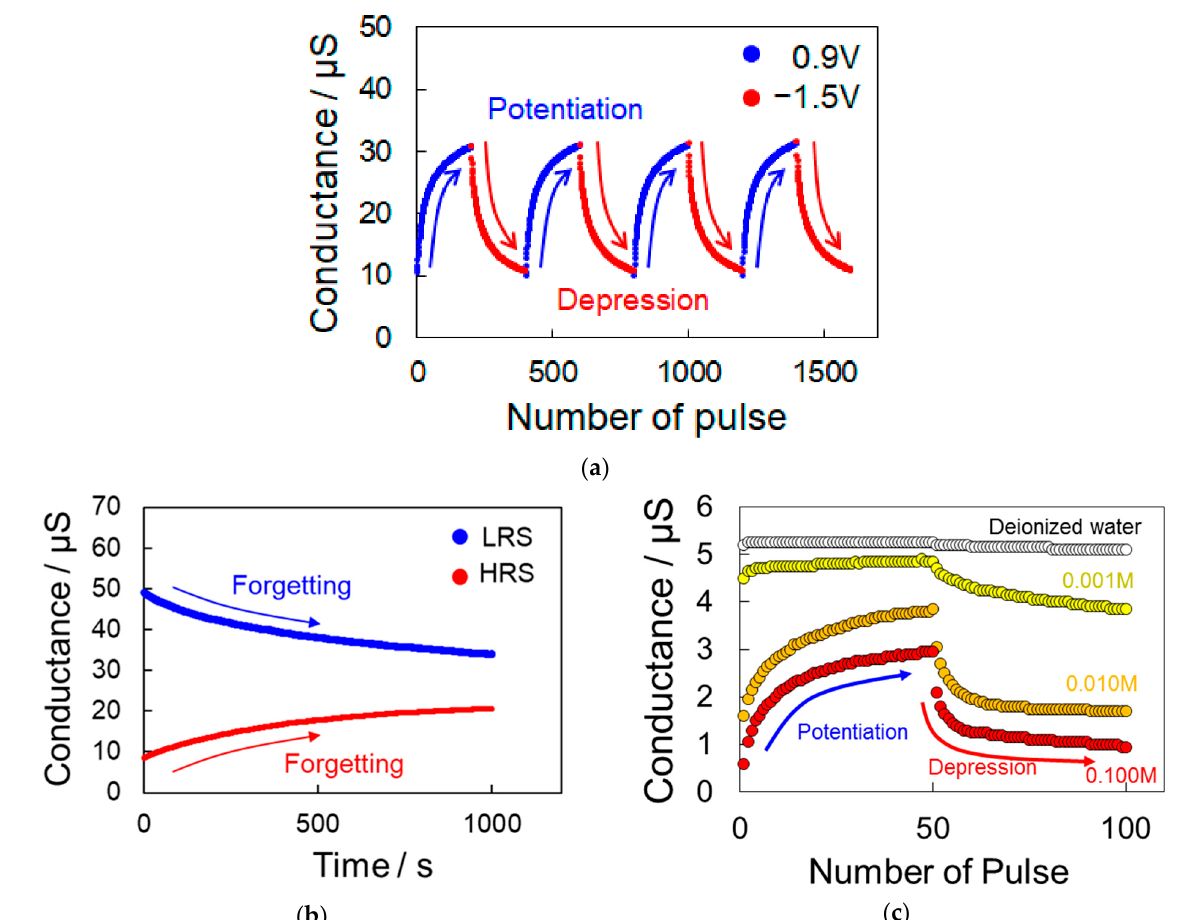
Figure 4. Expression of synaptic short-term plasticity (STP) characteristics due to the application of small periodic voltage pulses ( V = 0.9 or − 1.5 V, W = 10 ms, T = 0.5 s) to the electrode gap linked by polymer wires with asymmetric diameters. ( a ) Synaptic conductance change behaviors between the electrodes due to switching of the applied pulse polarity every 200 pulses. ( b ) State-retention curves for the polymer wire synapse with an open-circuit after being set to high-resistance state (HRS) or low-resistance state (LRS). ( c ) One cycle of synaptic conductance change behaviors due to switching of the applied pulse polarity every 50 pulses with increasing PSS dopant concentration from 0 to 0.1 M.